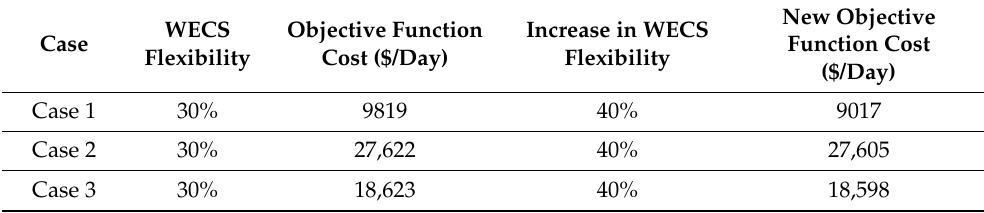
Table 2. Reduction in objective function